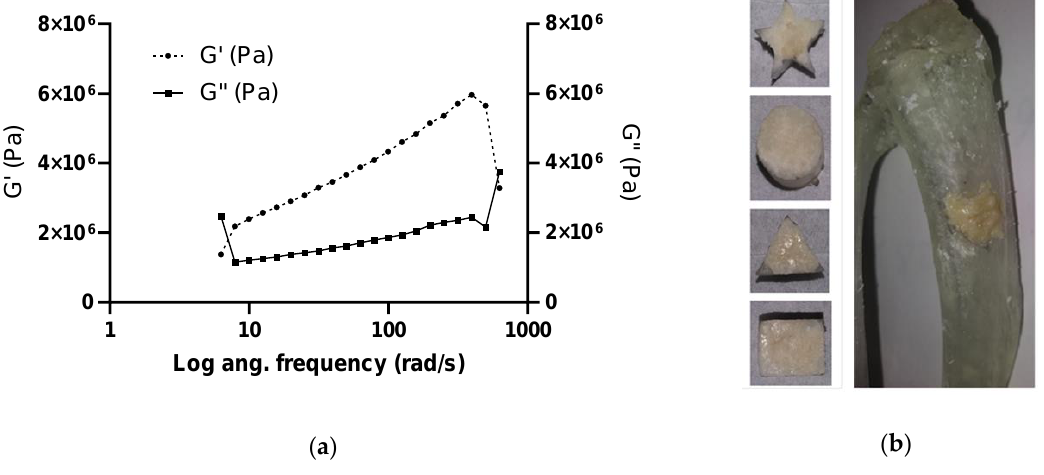
Figure 2. ( a ) Storage (G′) and loss modulus (G′′) of ABVF putty at an increasing angular frequency at room temperature (25 °C). ( b ) Press-fitting of ABVF putty in different 3D printed shapes and in a defect created in a 3D printed rat tibia. The ABVF putty could be easily press-fitted into shapes and seemed to contact the surrounding surfaces completely, without leaving any void spaces.